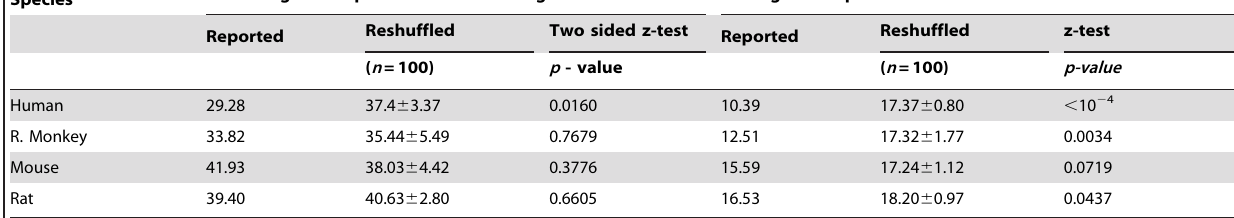
Table 2. Role of sequence motifs in mtDNA deletions.